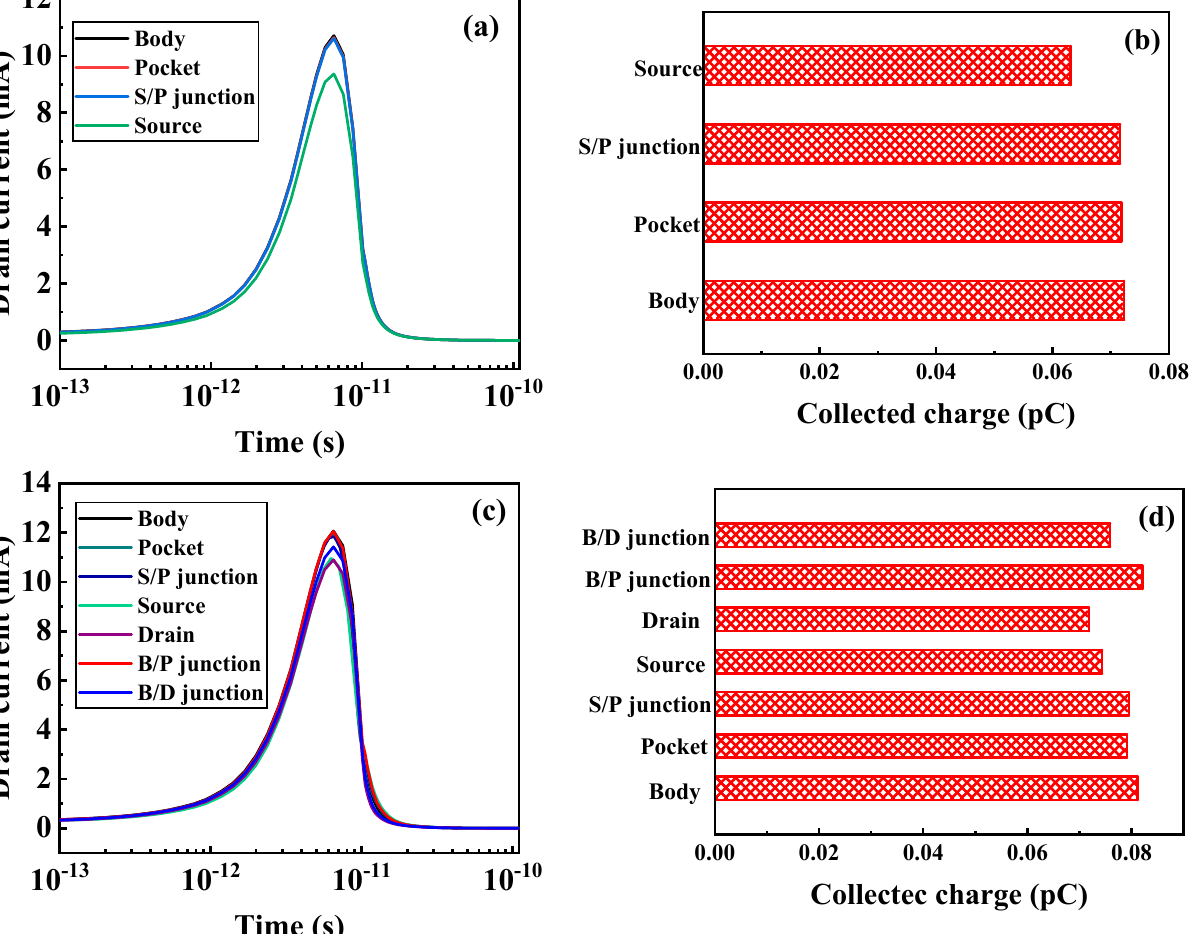
Figure 4. Simulated ( a ) drain transient currents and ( b ) collected charges for four vertical ion hit locations, and ( c ) drain transient currents and ( d ) collected charges for seven horizontal ion hit locations in TGTFET devices at LET = 100 MeV · cm 2 /mg and V d = 0.5 V.